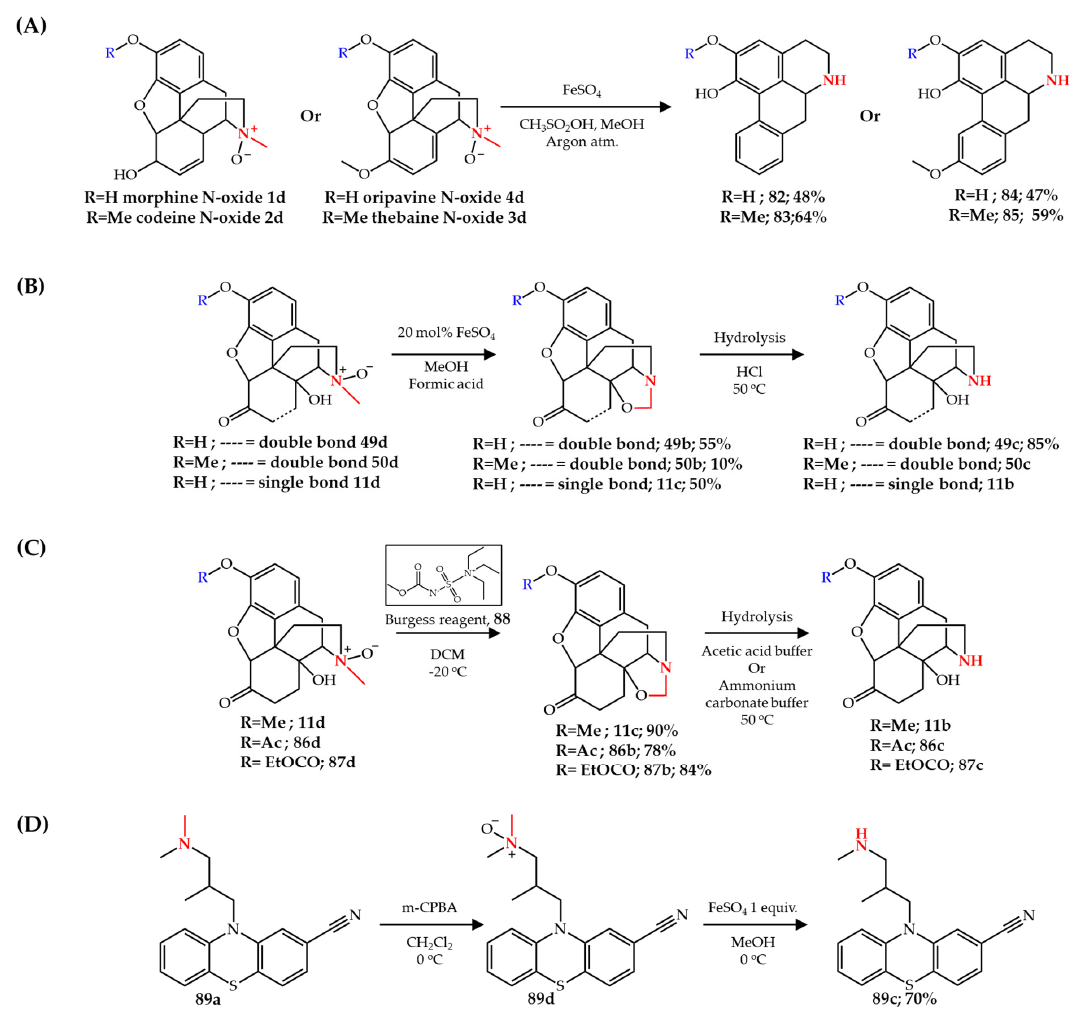
Figure 12. (A ) Rearrangement and N ‐ demethylation of aporphines, ( B , C ) oxazolidination of opiate N ‐ oxides, and ( D ) N ‐ demethylation of cyamemazine via N ‐ oxide formation.